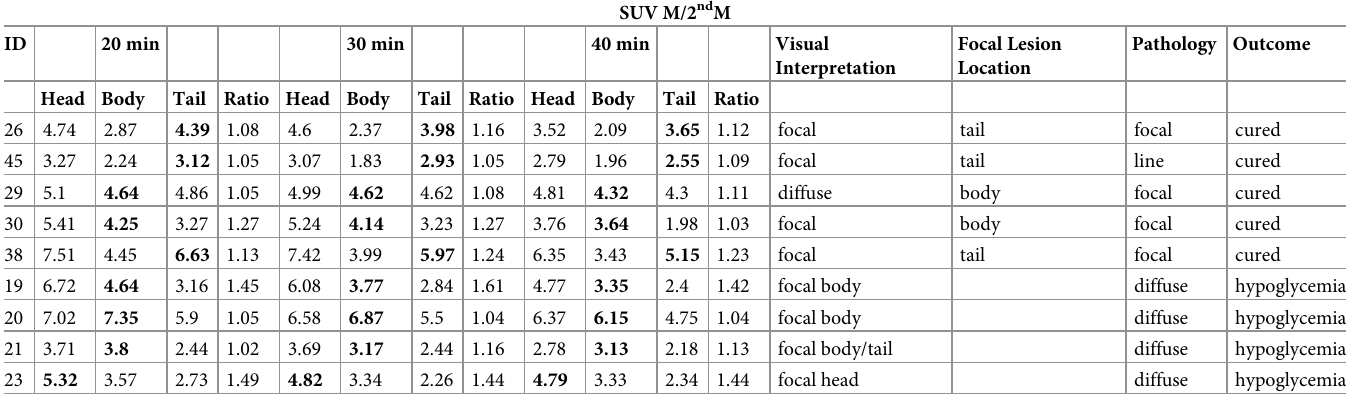
Table 4. Individual SUV values in patients with mismatch between visual findings and peak SUV and location of lesion.